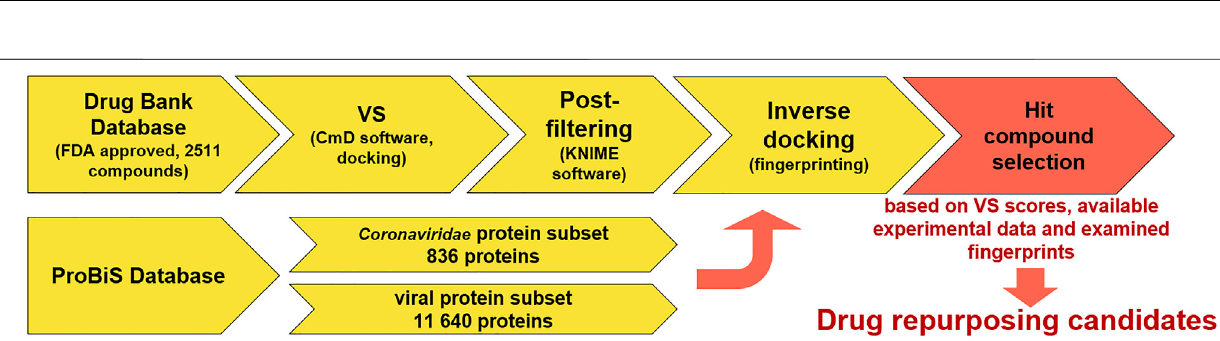
Frontiers in Chemistry |